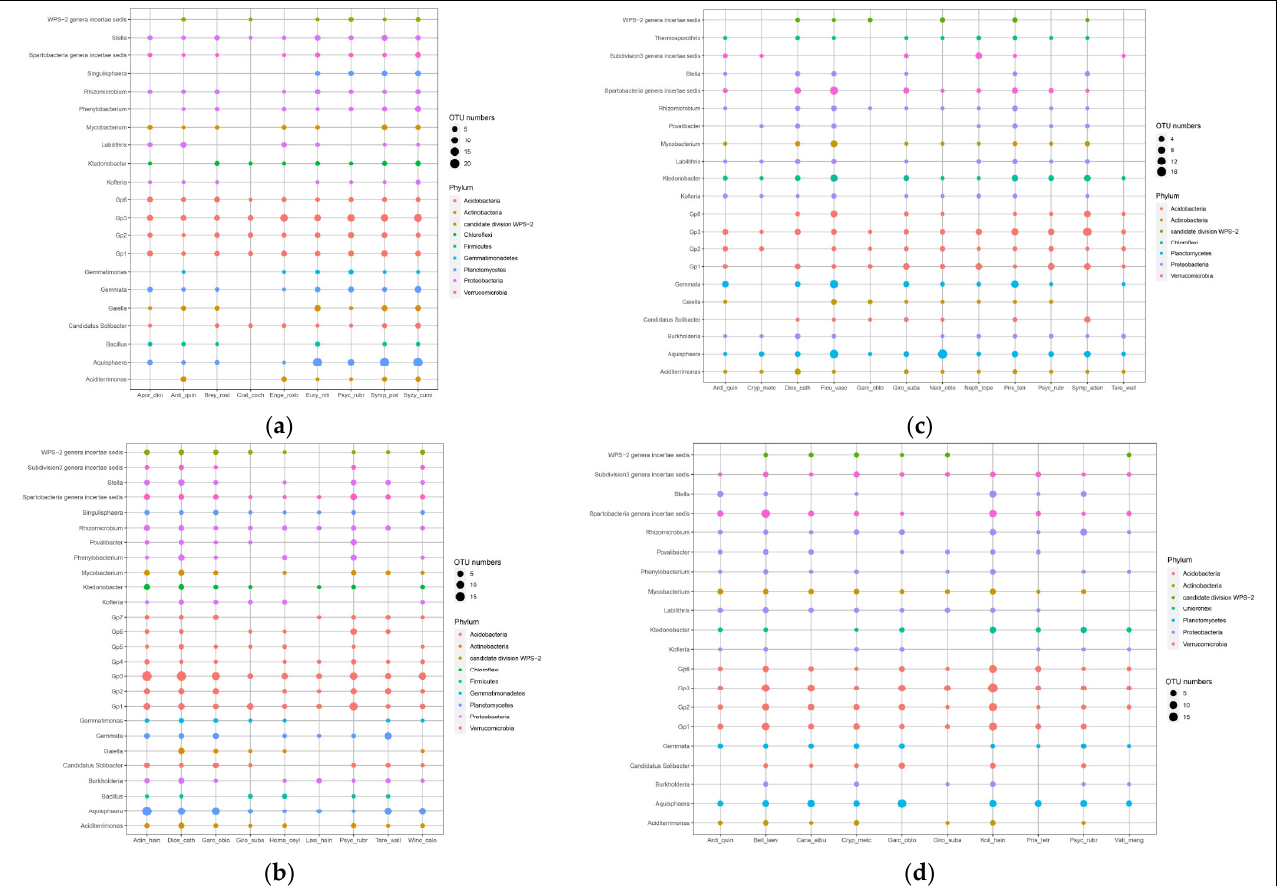
Figure 3. Bacteria genera associated with plants. The different colors indicate bacterial taxonomy at phylum level. ( a – d ) represent SB (slash-and-burn), CC (clear cutting), SL (selective cutting) and OG (old growth forests) forest stands, respectively.